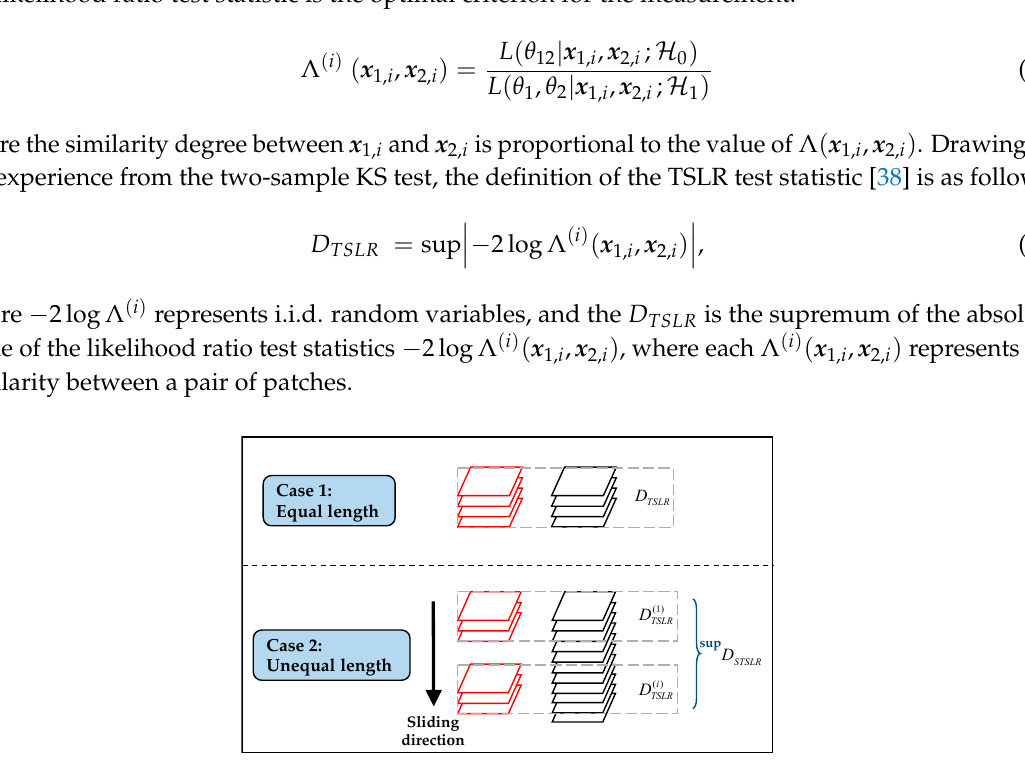
Figure 2. Two cases in multi-date analysis using the sliding time-series likelihood ratio (STSLR) test.